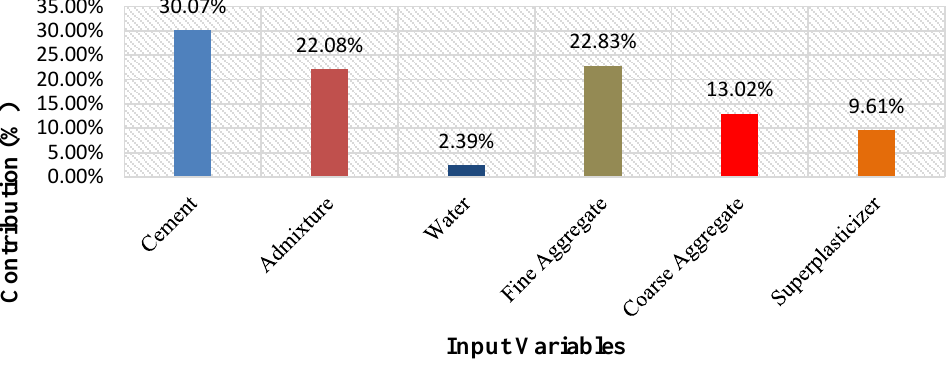
Figure 17. Contribution of input variables to split tensile strength of SSSC with RA in BR approach.